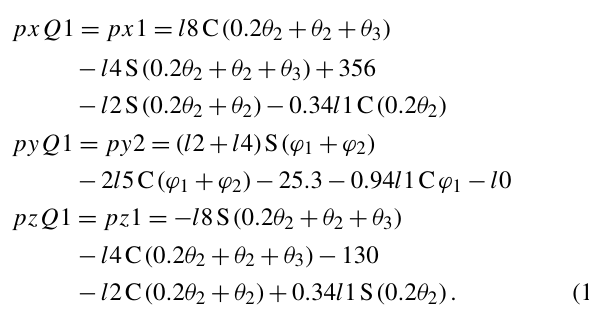
Figure 13. Modeling of the exoskeleton.